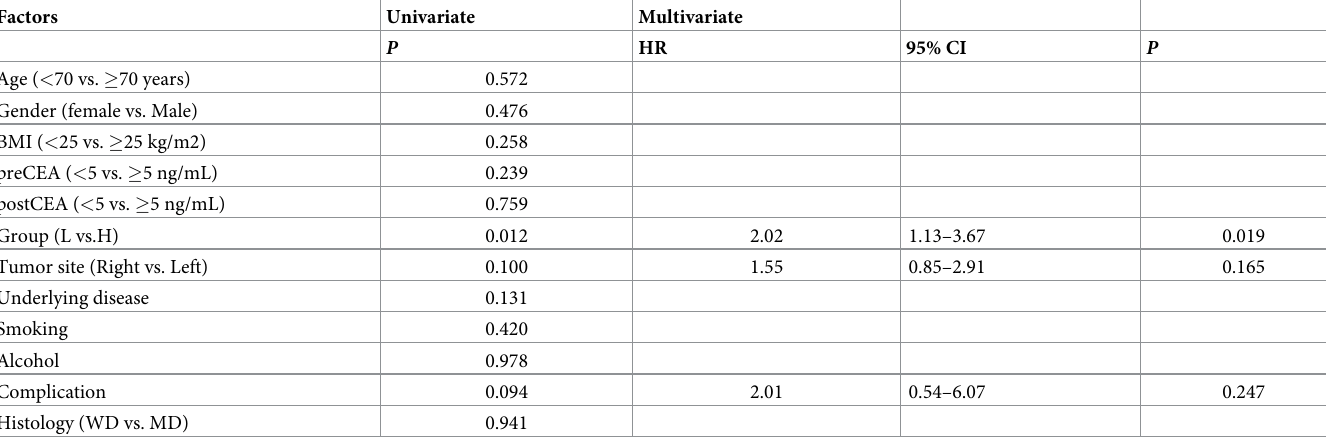
Table 5. Uni- and multivariate analysis of risk factors associated with recurrence using Cox regression model.